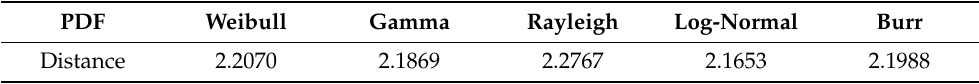
Table 2. Distances between the histogram and each probability distribution function (PDF).